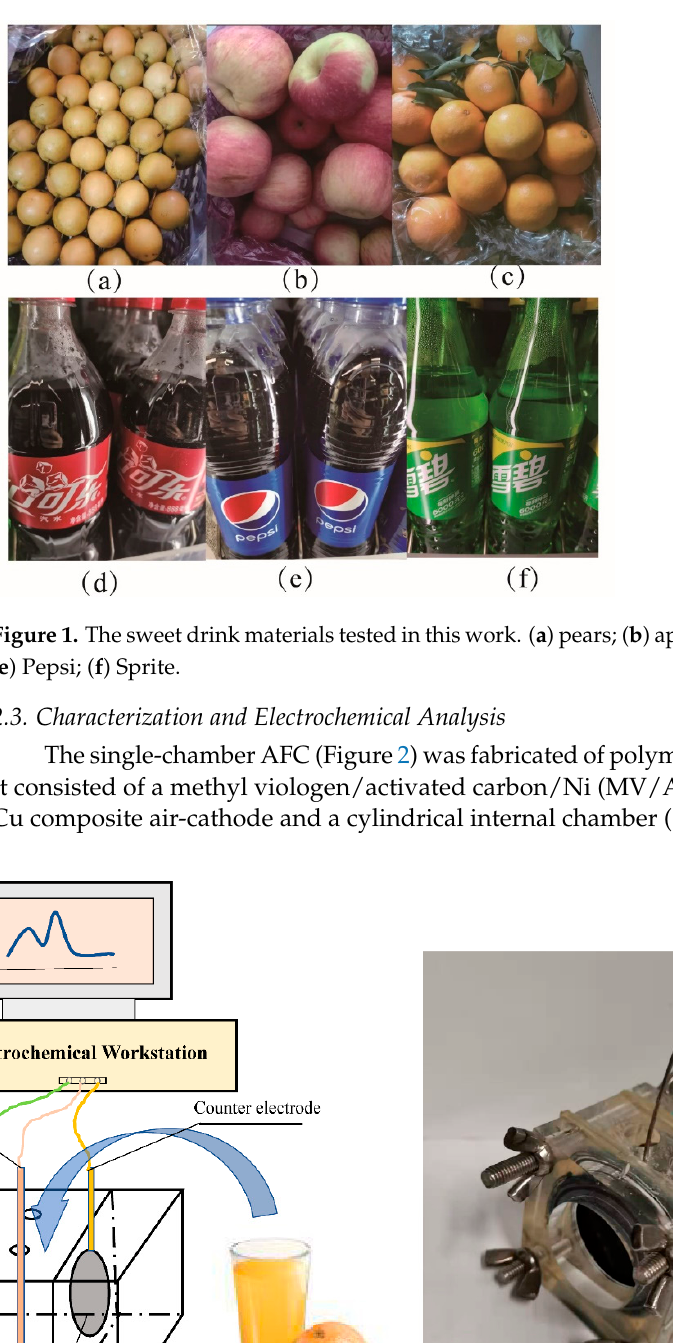
Figure 2. Schematic diagram ( a ) and photograph ( b ) of the AFC used in this study.